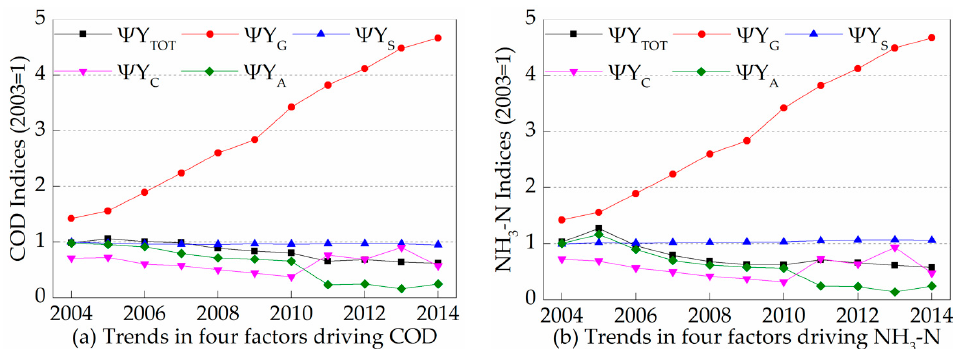
Figure 3. Trends in the cumulative decomposition of the indices of COD and NH 3 -N discharge. Ψ Y TOT , Ψ Y A , Ψ Y C , Ψ Y S and Ψ Y G denote the total change and the effects of pollution abatement, clean production, industrial structure and economic output, respectively, on the discharge of the two pollutants. ( a ) Trends in four factors driving COD and ( b ) trends in four factors driving NH 3 -N. Water 2017 , 9 , 201